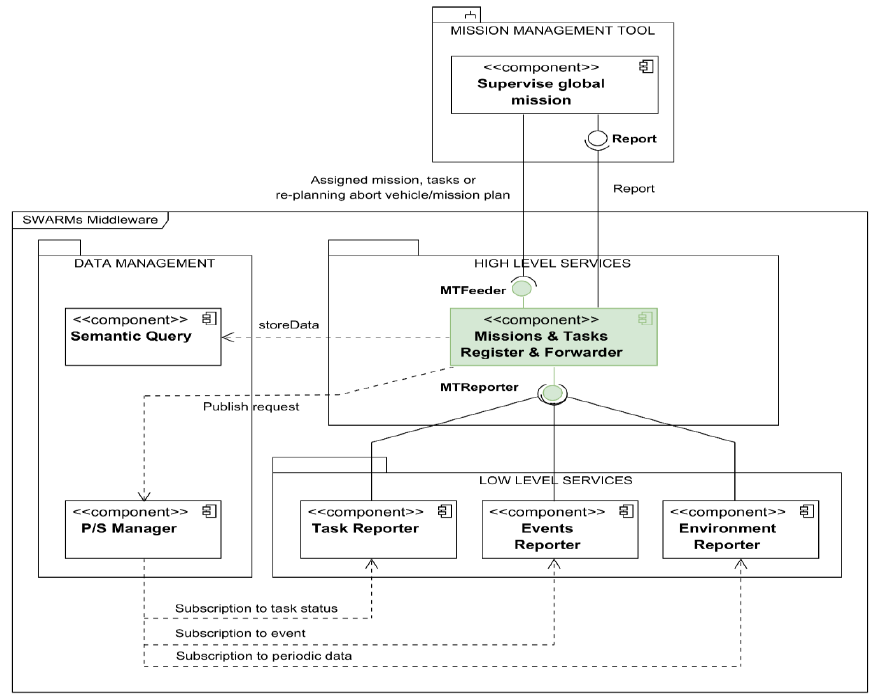
Figure 5. MTRR-centered SWARMs components diagram.